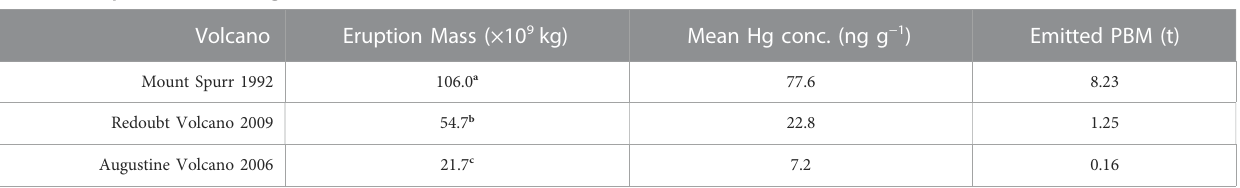
TABLE 2 Total particulate-bound Hg from each